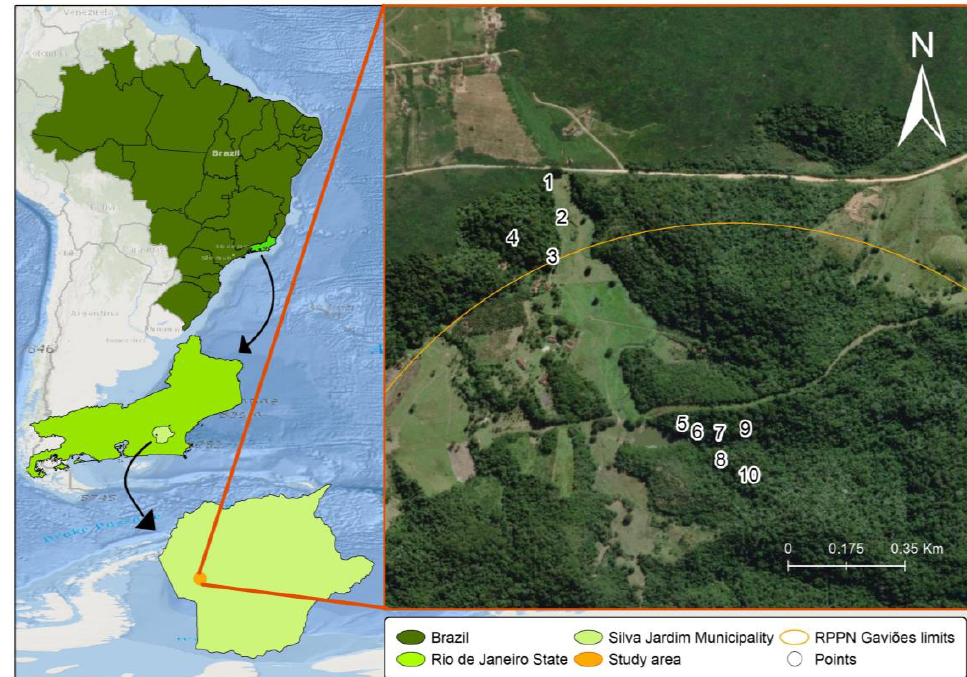
Figure 1. Sampling sites in the Sana Environmental Protection Area of the Private Reserve of the Gaviões Natural Heritage (RPPN Gaviões), Rio de Janeiro, Brazil. Maps were prepared using the QGIS 3.14.16 software and edited in Adobe Photoshop CS5 and CorelDraw X5. Reprinted from QGIS 3.14.16, a program under a CC BY license, with permission from Jeronimo Alencar — Fiocruz,